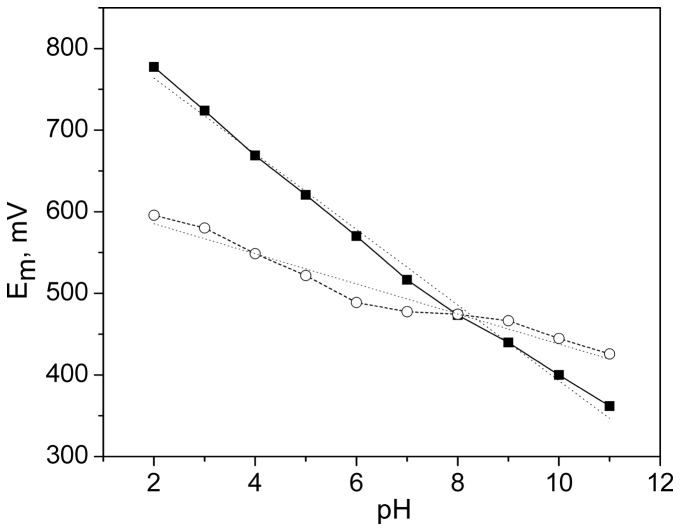
Calculated pH - dependence of the Em of ZnCe6 in BFR-RC (solid line, slope −46.4, R = 0.994) and in water (dashed line, slope −18.4, R = 0.950).